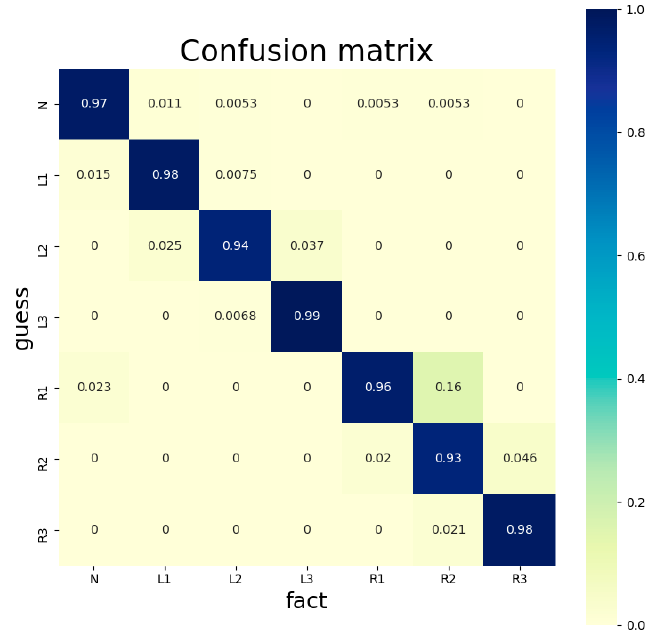
Figure 4. Confusion Matrix.